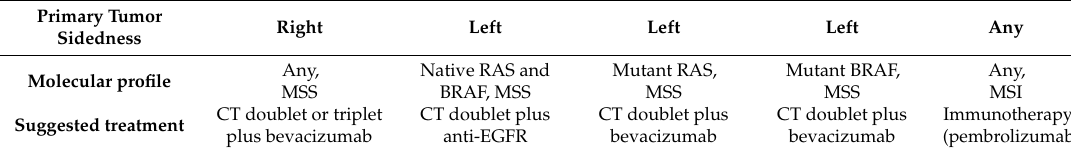
Table 2. Current recommendations for first-line treatment according to the individual molecular profile and tumor